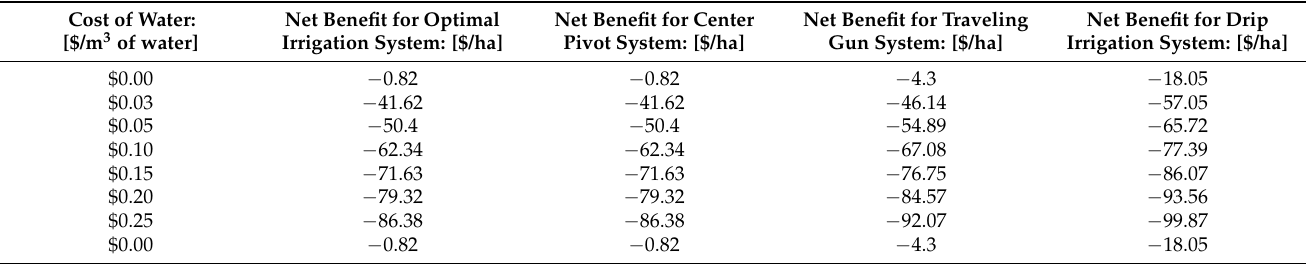
Net Benefit for Optimal Irrigation System: [$/ha]